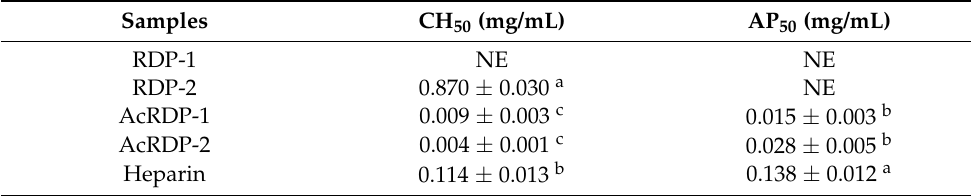
Table 3. Anticomplementary activities of unmodified and acetylated polysaccharides.